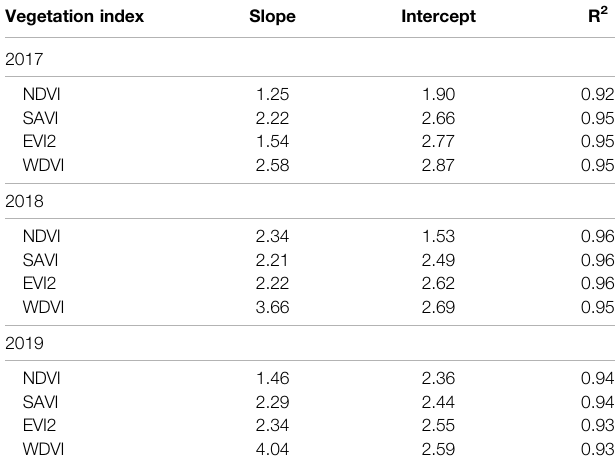
TABLE 1 | Slope and intercept of linear regression models developed using eddy covariance-based gross primary production and the product of vegetation index, leaf area index, photosynthetically active radiation. Vegetation indices that were studied include the normalized difference vegetation index (NDVI), the soil adjusted vegetation index (SAVI), the enhanced vegetation index 2 (EVI2), and the weighted difference vegetation index (WDVI). R 2 is the coef fi cient of